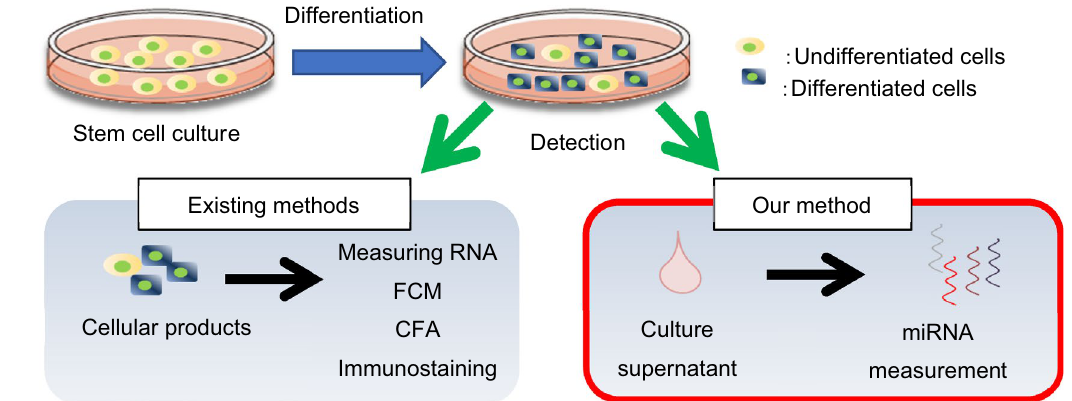
Figure 1. Schematic representation of the concept of our novel method for detecting residual undifferentiated cells using miRNAs in culture